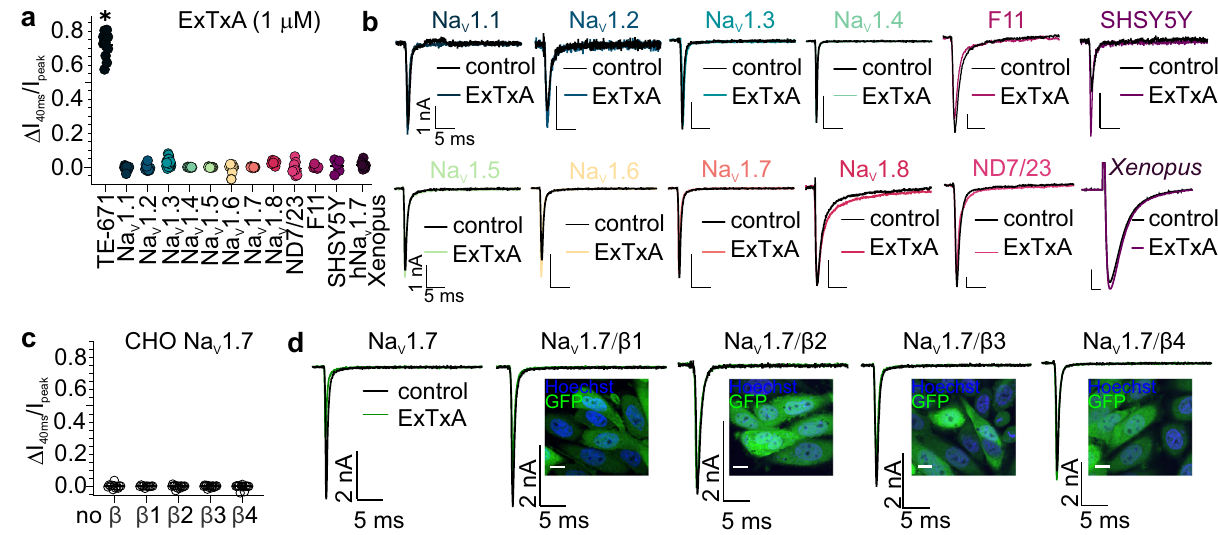
Fig. 2 | ExTxA does not inhibit Na V 1.7 inactivation heterologous expression systems.a Persistent current ( I 40 ms / I peak ) induced by ExTxA (1 μ M) in TE-671 cells, HEK293 cells stably expressing β 1 and hNa V 1.1, hNa V 1.2, hNa V 1.3, hNa V 1.4, hNa V 1.5, hNa V 1.6, hNa V 1.7 or CHO cells expressing hNa V 1.8/ β 3, ND7/23 cells, F11 cells, SH- SY5Y neuroblastoma cells and Xenopus oocytes expressing hNa V 1.7. b Representative control (black) and ExTxA-treated (1 μ M, colored) normalized current traces of data shown in ( a ). Current was elicited by a depolarizing step to − 20mV( − 10mVforoocytes)fromaholdingpotentialof − 90mV.Scalebar:all1nA,